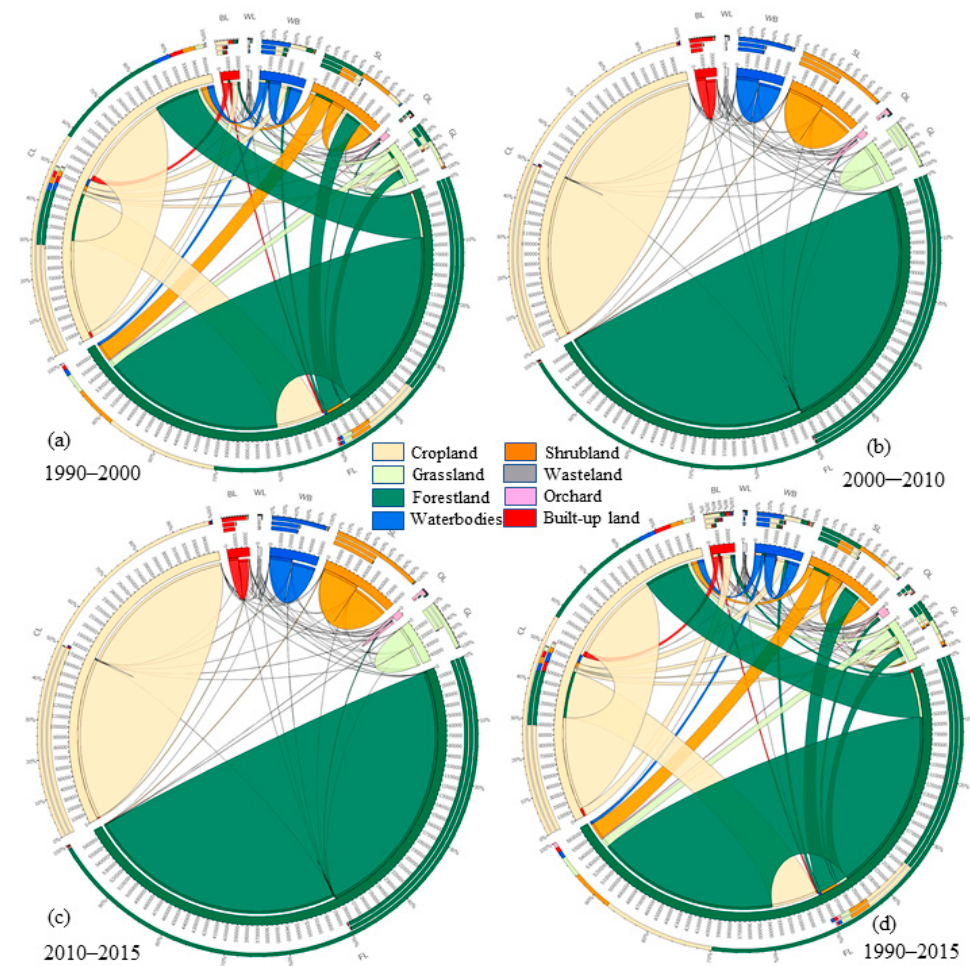
Figure 5. Land use transfer flow charts in the MRYRR from 1990 to 2015. ( a ) Land use transfer flow chart from 1990 to 2000. ( b ) Land use transfer flow chart from 2000 to 2010. ( c ) Land use transfer flow chart from 2010 to 2015. ( d ) Land use transfer flow chart from 1990 to 2015.